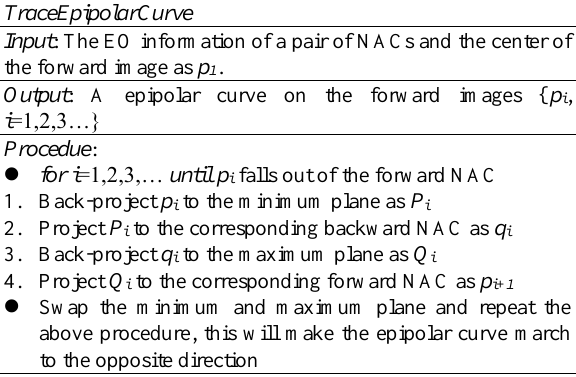
Table 2. Information of the experimental stereo pair.